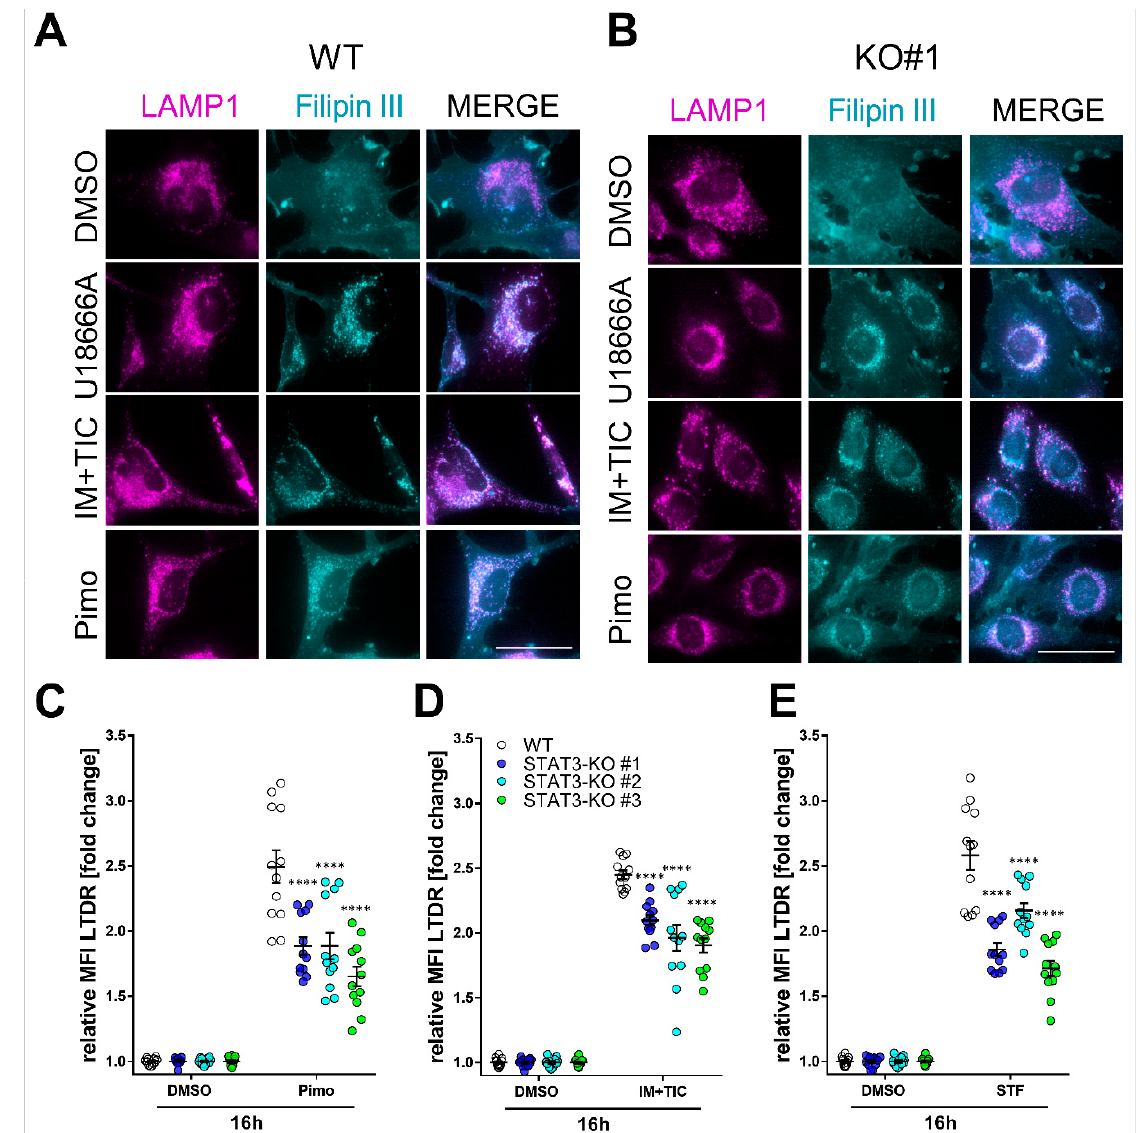
Figure 4. Depletion of STAT3 reduces lysosomal cholesterol accumulation and lysosomal acidification. ( A , B ) Representative pictures of ( A ) MZ-54 WT cells and ( B ) STAT3-KO#1 cells stained with Filipin III and against LAMP1 after treatment with 15 µ M Pimozide (Pimo), 40 µ M STF-62247 (STF), 20 μ M imipramine (IM) and 100 μ M ticlopodine (TIC) or vehicle (DMSO) for 18 h. Scale bar: 50 μ m. As a positive control the cells were treated with 1.25 μ M of the cationic, amphiphile U18666A that inhibits intracellular cholesterol trafficking [62] . Note that white punctae in the merged image indicates cholesterol accumulation within the lysosomes, which is reduced in STAT-KO cells. ( C – E ) Quantification of lysosomal acidification of MZ-54 WT and STAT3-KO cells using lysotracker deep red after treatment as in ( A , B ) for 16 h. The data are presented as point-plots of three experiments performed in 4 replicates. ****: p < 0.0001; Two-way ANOVA with Sidak’s multiple comparison (GraphPad Prism 7).